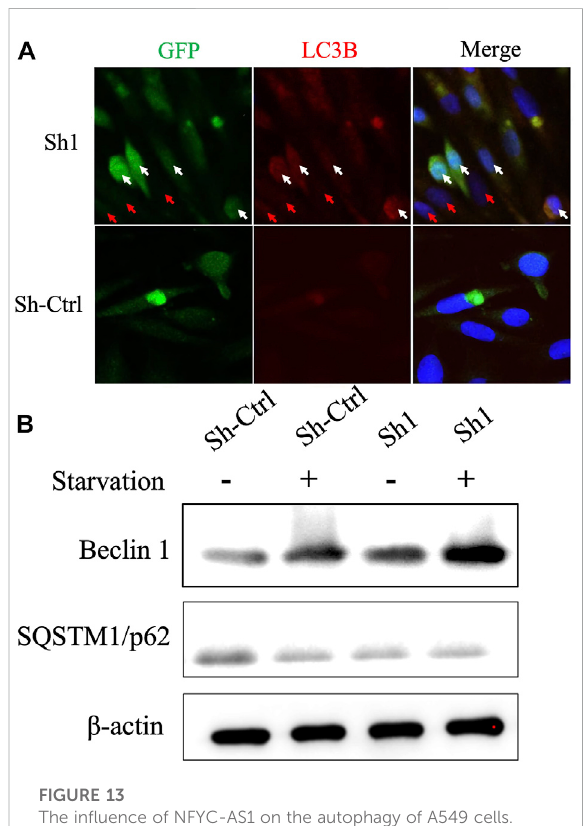
FIGURE 13 The in fl uence of NFYC-AS1 on the autophagy of A549 cells. (A) Immuno fl uorescence analysis of key autophagy marker LC3B in A549 cells with or without knockdownof NFYC-AS1 expression. Thewhitearrowindicatesthesigni fi cantexpressionofshRNA plasmids, whereas the red arrow indicates a less signi fi cant expression. (B) Immunoblot of Beclin 1 and SQSTM1/ p62expressioninA549cellswithorwithoutknockdownofNFYC- AS1